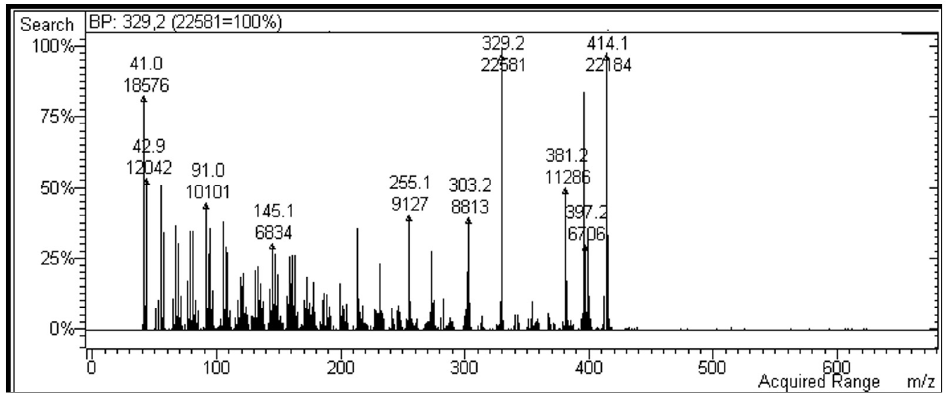
Fig. 7. Mass spectra of isolated compounds of fraction D8.3.5.7.